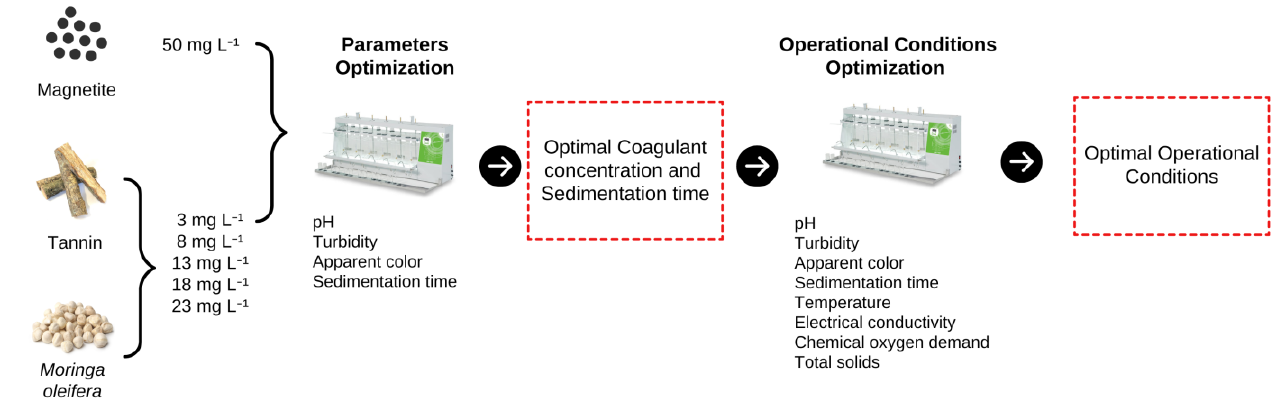
Figure 2. Scheme of experimental design for parameters and operational conditions optimization using central composite rotational design (CCRD). using central composite rotational design